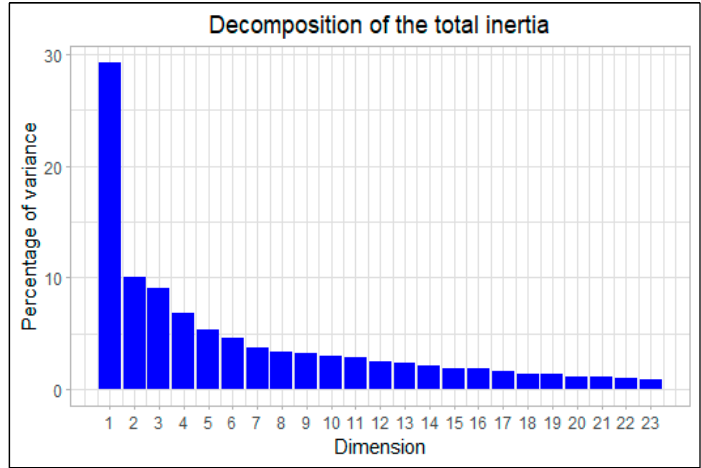
Figure 1. Decomposition of the total inertia.